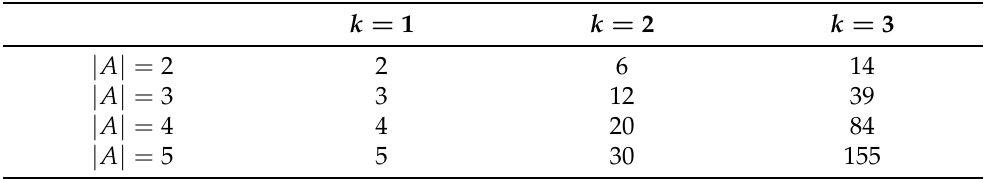
Table 4. Number of possible sequences, with respect to the number of distinct actions chosen maximum number of actions per sequence k